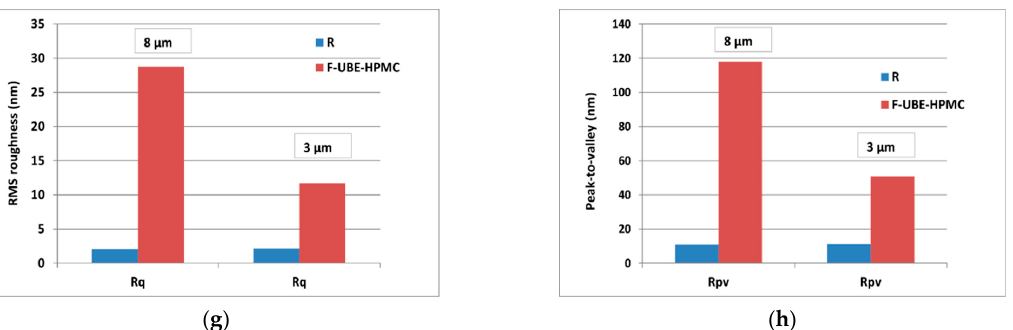
Figure 1. SEM images of R ( a ) and F-UBE-HPMC ( b ); 2D-AFM images (enhanced contrast view) at the scale of (8 × 8) µm 2 together with representative line scans for R ( c ) and F-UBE-HPMC ( d ). Roughness (Rq) and peak-to-valley (Rpv) parameters for the whole scanned areas at (8 × 8) µm 2 and (3 × 3) µm 2 ( e , f ) and along the line scans over 8 µm and 3 µm ( g , h ). F-UBE-HPMC—mucoadhesive oral patches loaded with UBE; UBE— U. barbata dry ethanol extract; R—Reference (mucoadhesive oral patches without UBE).